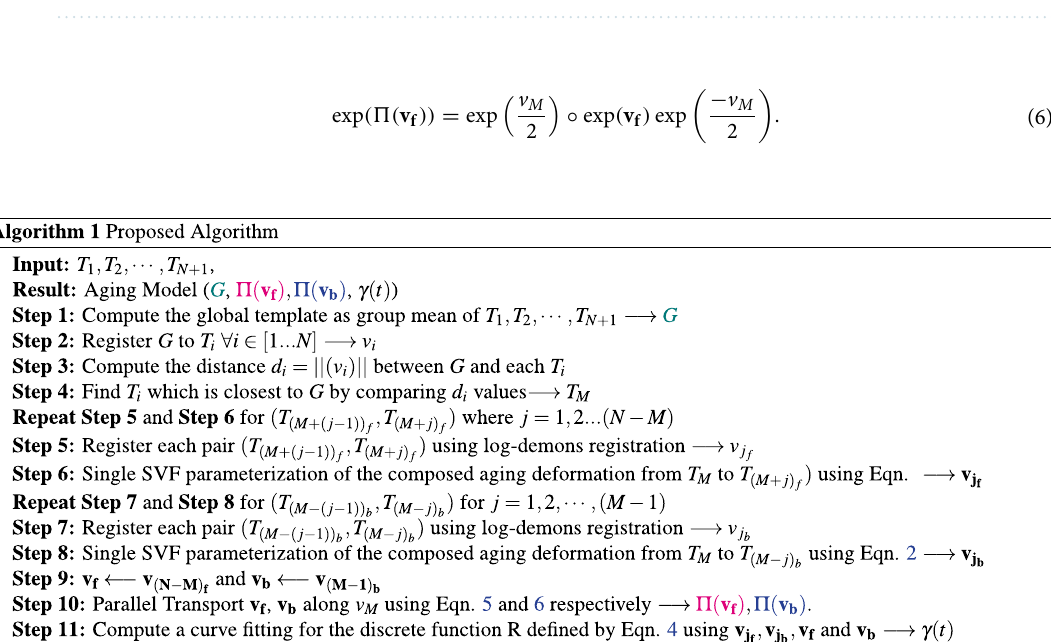
Figure 3. T M is mapped to G using exp ( v M ) and the path is used to transport exp ( v f ) and exp ( v b ) to the global template